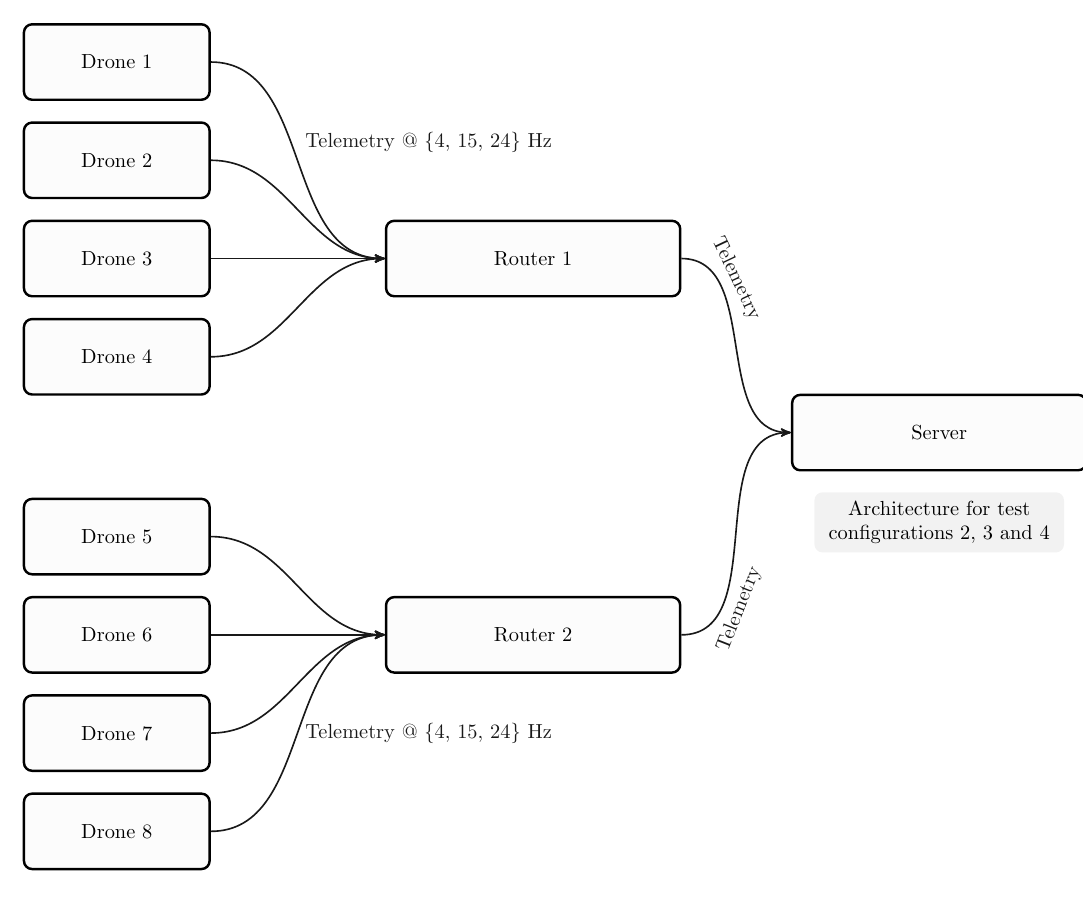
Figure 16. Test architecture for